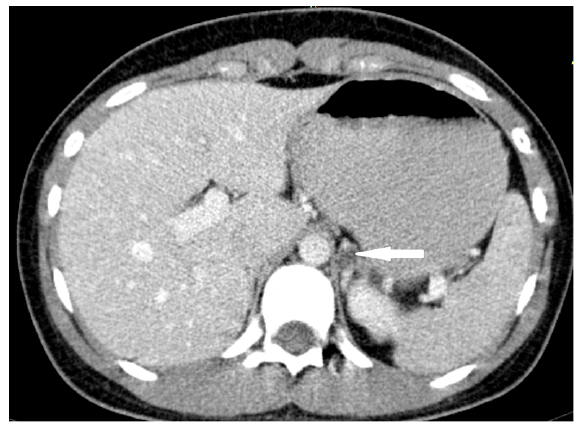
Figure 7. Adrenal lymphangioma. Abdomen CT, transverse cross-section.